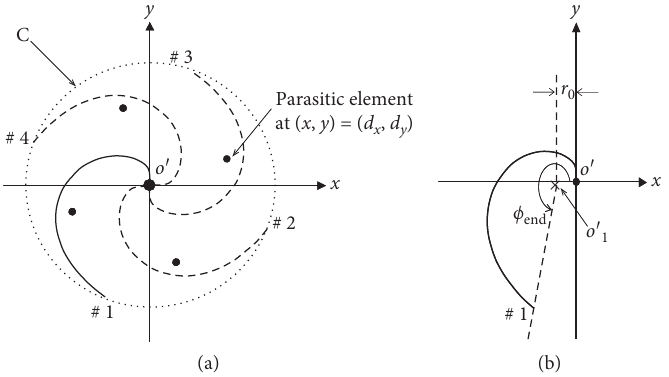
Figure 3: Spiral-type antenna. (a) Arms # n ( n � 1, 2, 3, and 4) with cross point o ′ . (b) Spiral origin o equiangular spiral function: r � r 0 · exp [ a s · { ϕ s − ( n − 1) · π /2}], where r is the radial distance from the spiral origin o n ′ to a point on the spiral arm # n , r 0 is the initial length of r , a s is a spiral constant, and ϕ s is a winding angle ranging ( n − 1) · π /2 ≤ ϕ s ≤ ( n − 1) · π /2 + ϕ end with ϕ end being the end winding